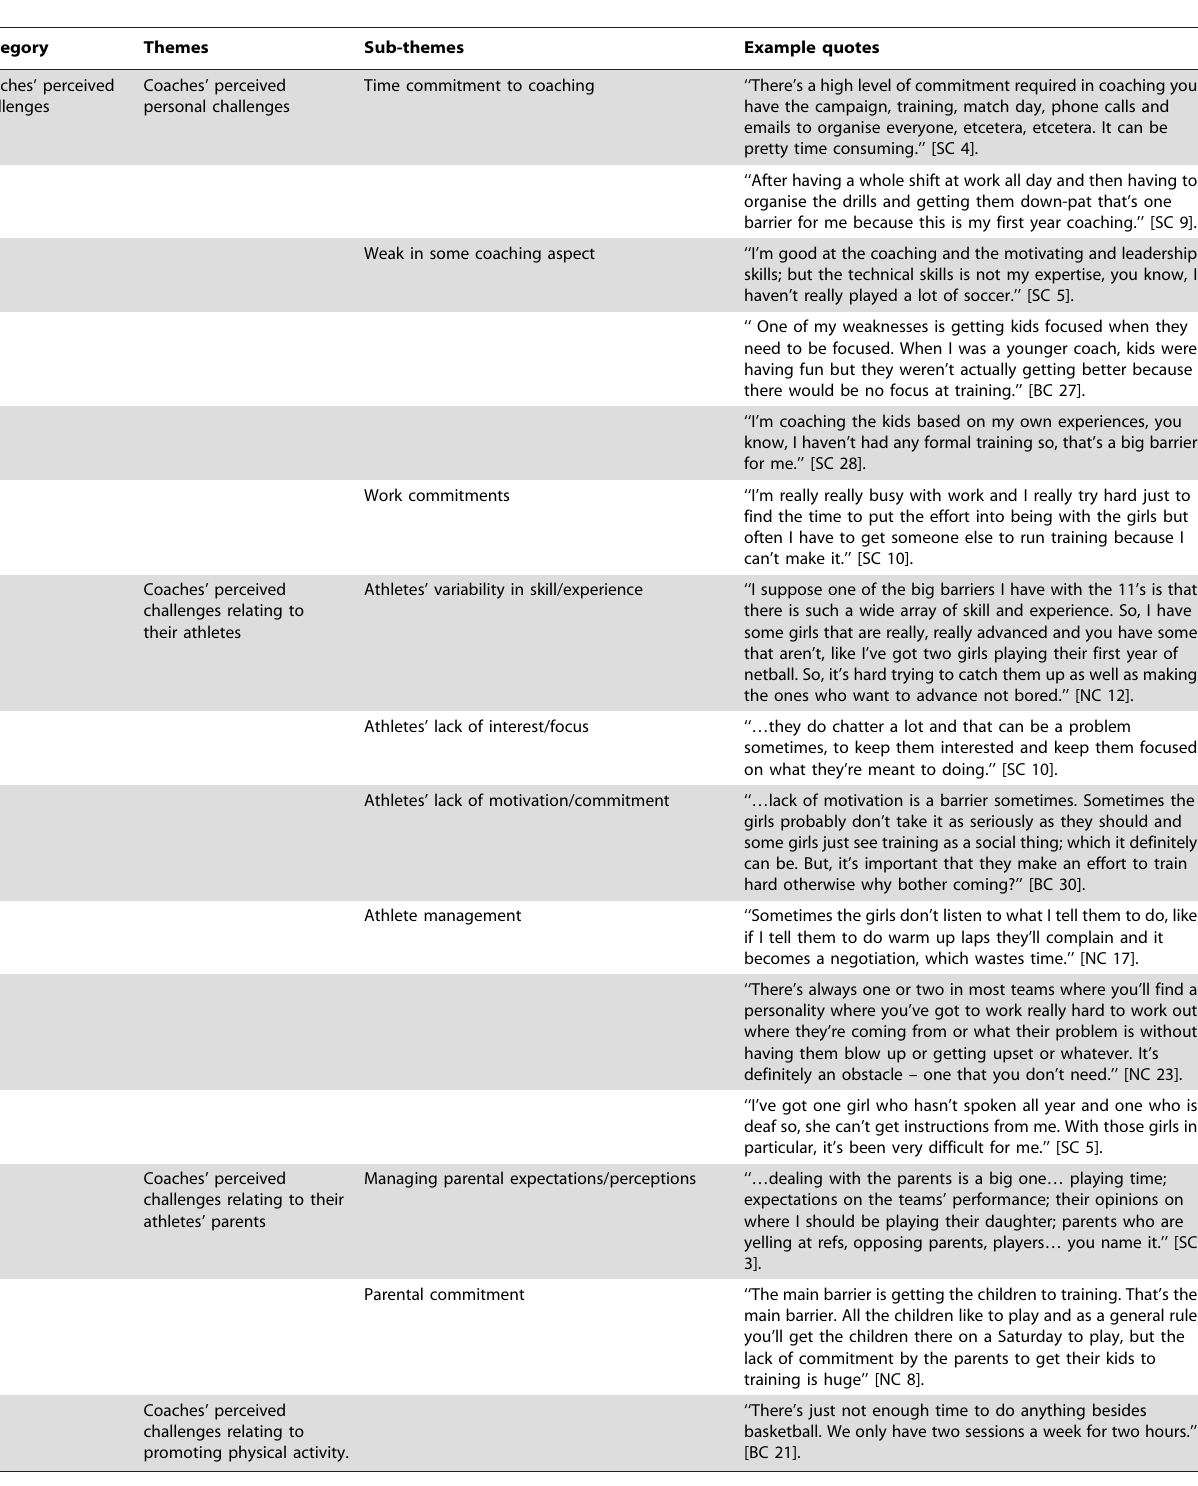
Table 7. Coaches’ perceived challenges: summary of categories, themes, sub-themes, and example